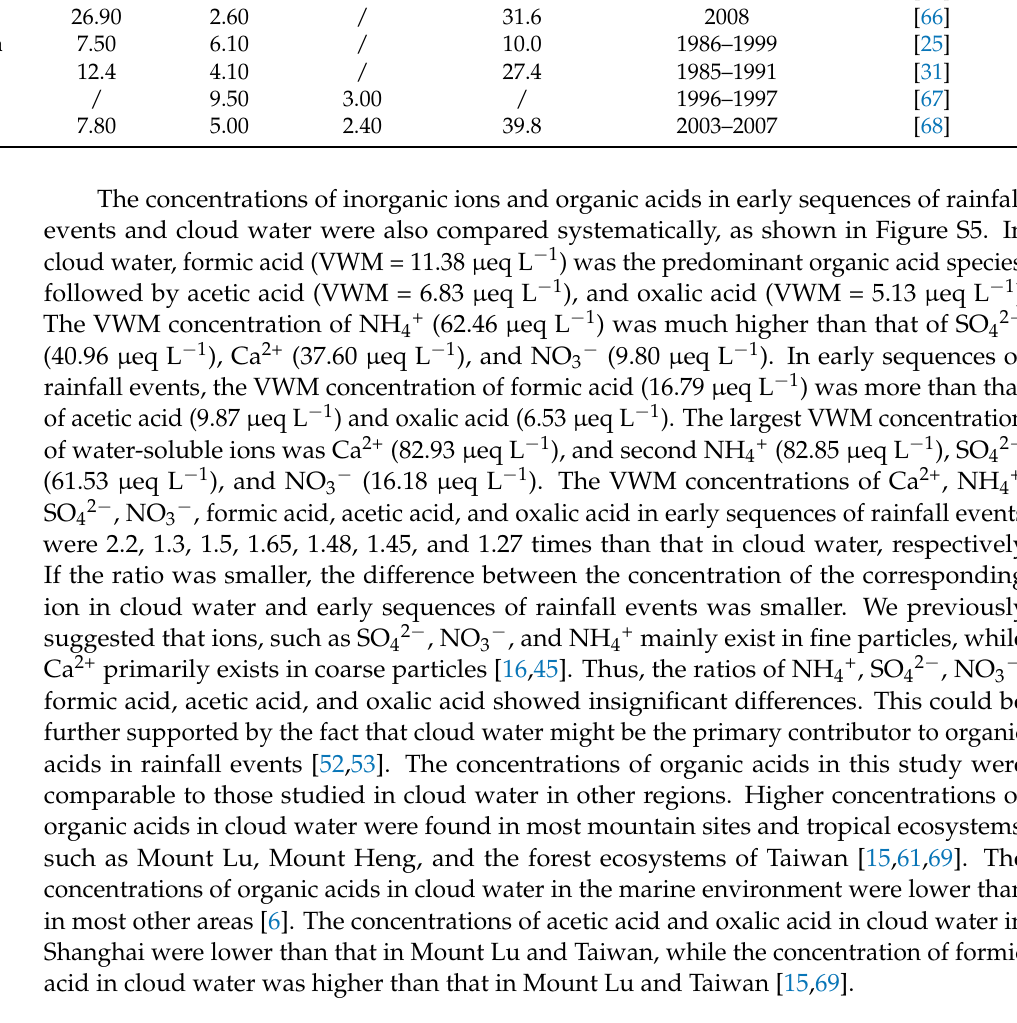
The concentrations of inorganic ions and organic acids in early sequences of rainfall events and cloud water were also compared systematically, as shown in Figure S5.